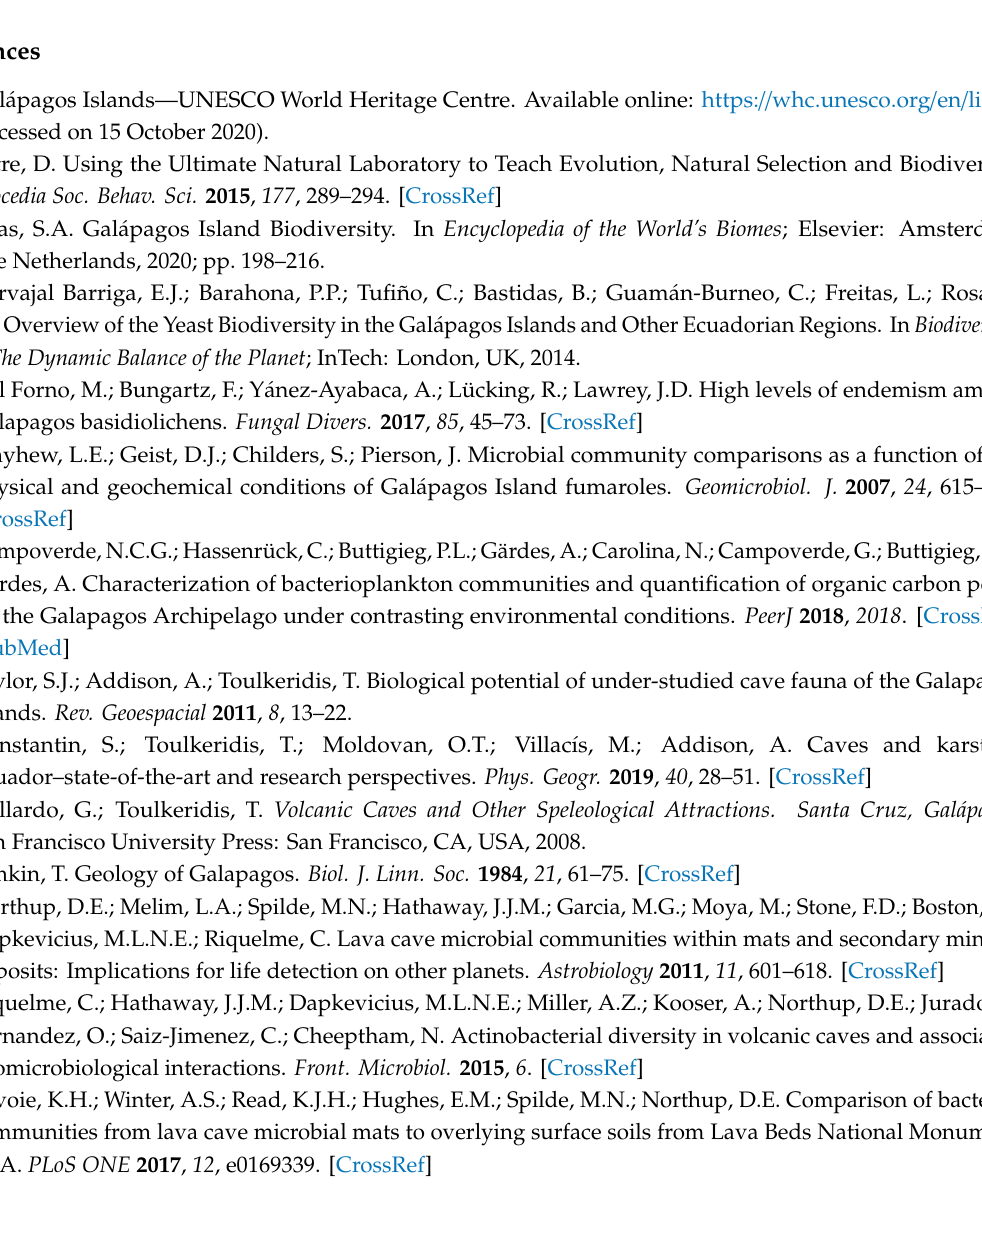
Table S1: Phylogenetic a ffi liations of the 16S rRNA gene sequences of total bacteria obtained from Bella 1 sample (145 sequences, 93 OTUs), Table S2: Phylogenetic a ffi liations of the 16S rRNA gene sequences of total bacteria obtained from Royal 2 sample (76 sequences, 70